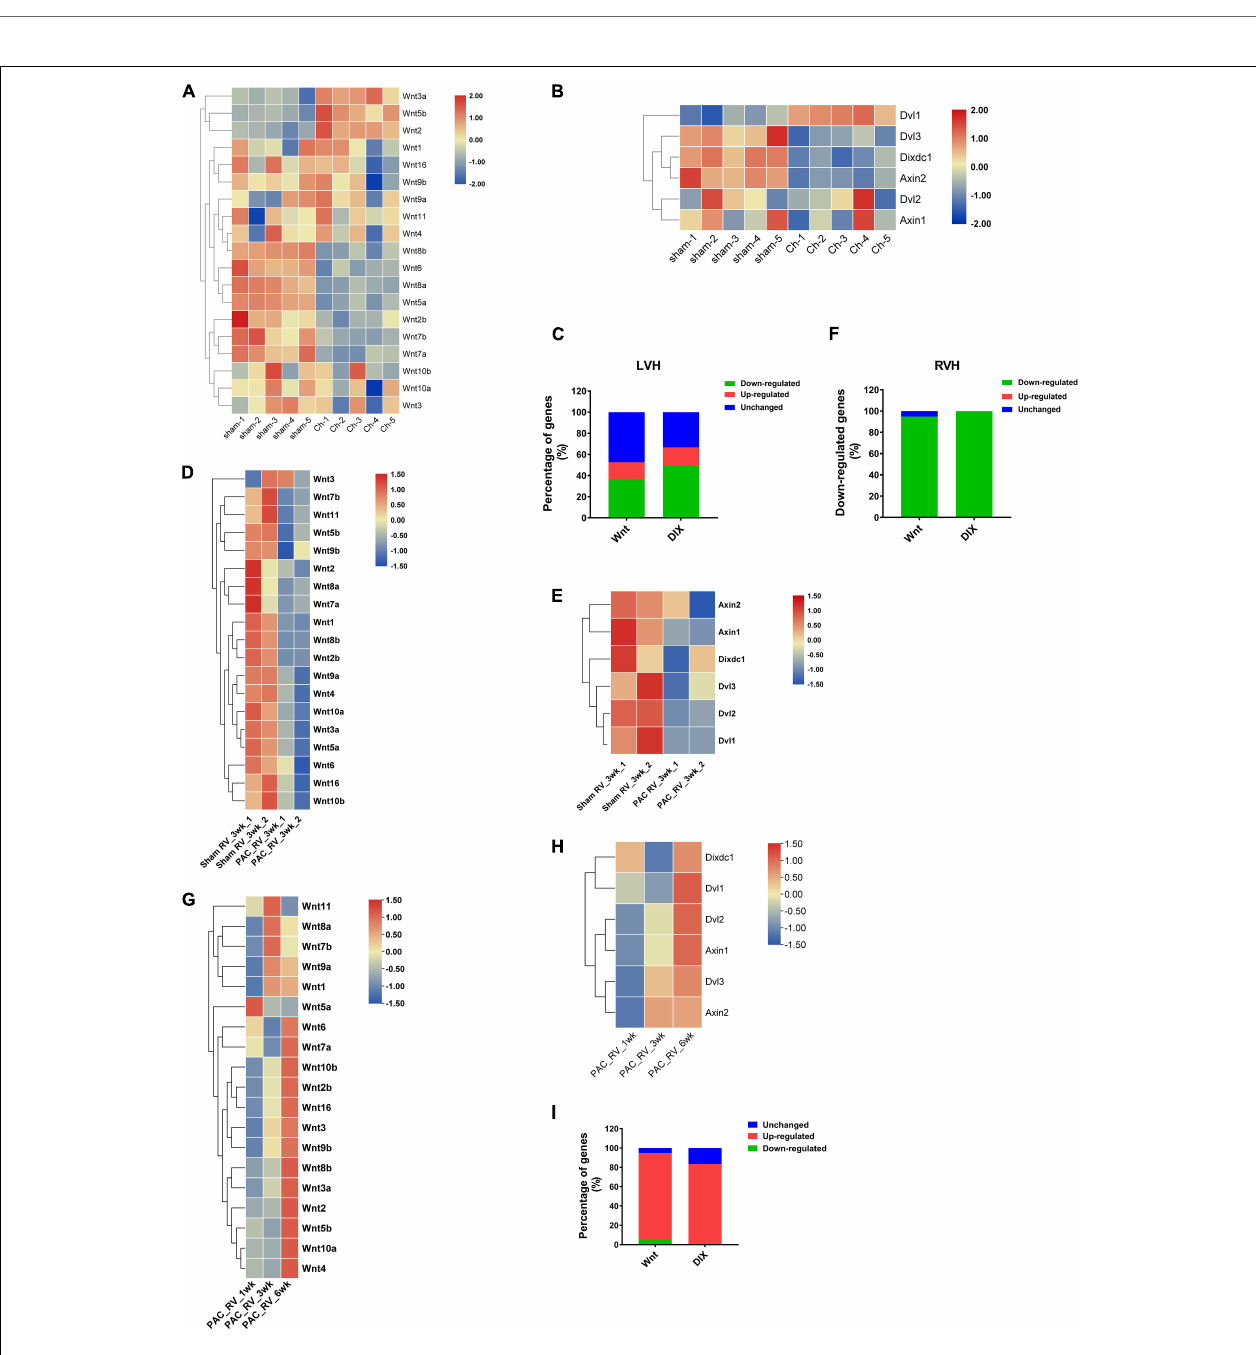
( Figure 7D ). Interestingly, all DIX family members were also downregulated in the right ventricle of RVH mice ( Figure 7E